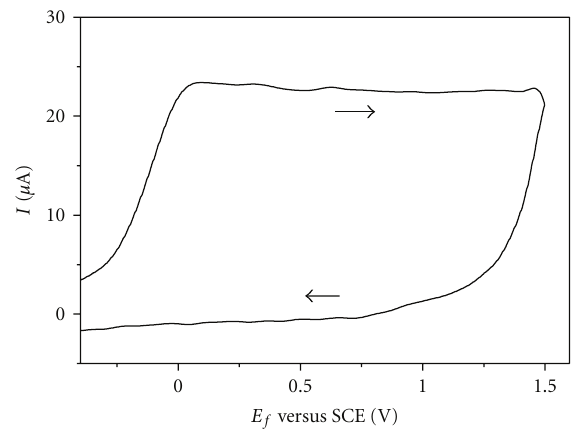
Figure 1: Cyclic voltammogram for Ti-grade 2 electrode in PBS solution at 50 mV · s − 1 and 25 ◦